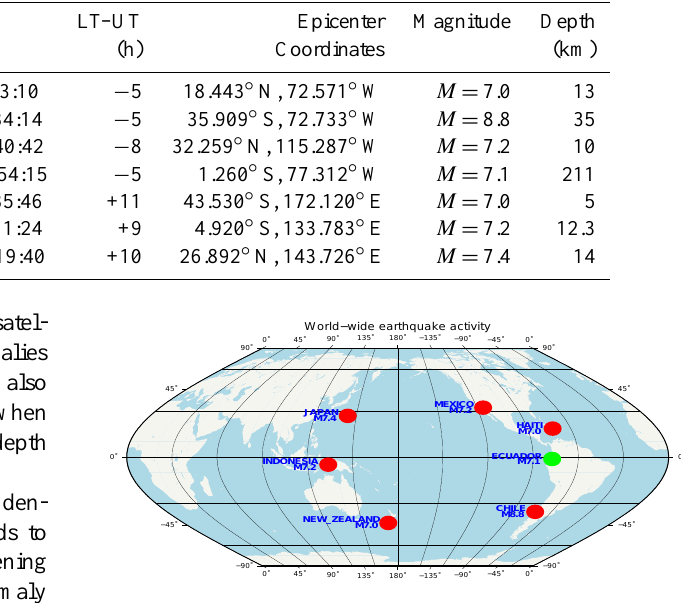
Fig. 1. Global distribution of the seven selected earthquakes.